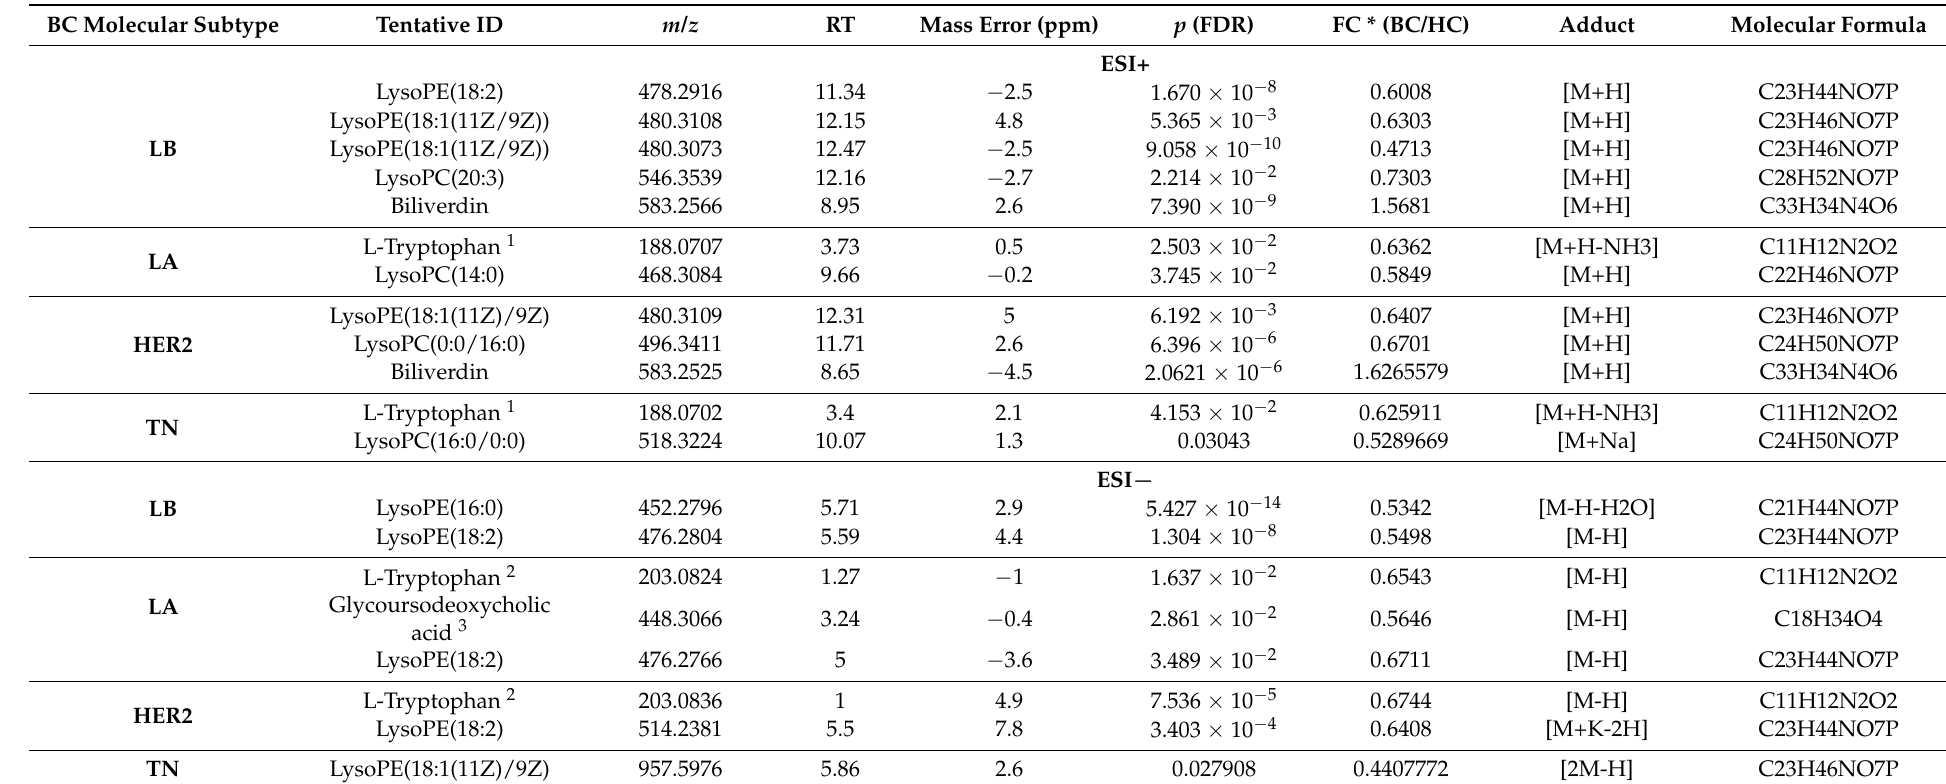
Table 1. Differential identified metabolites of molecular subtypes in